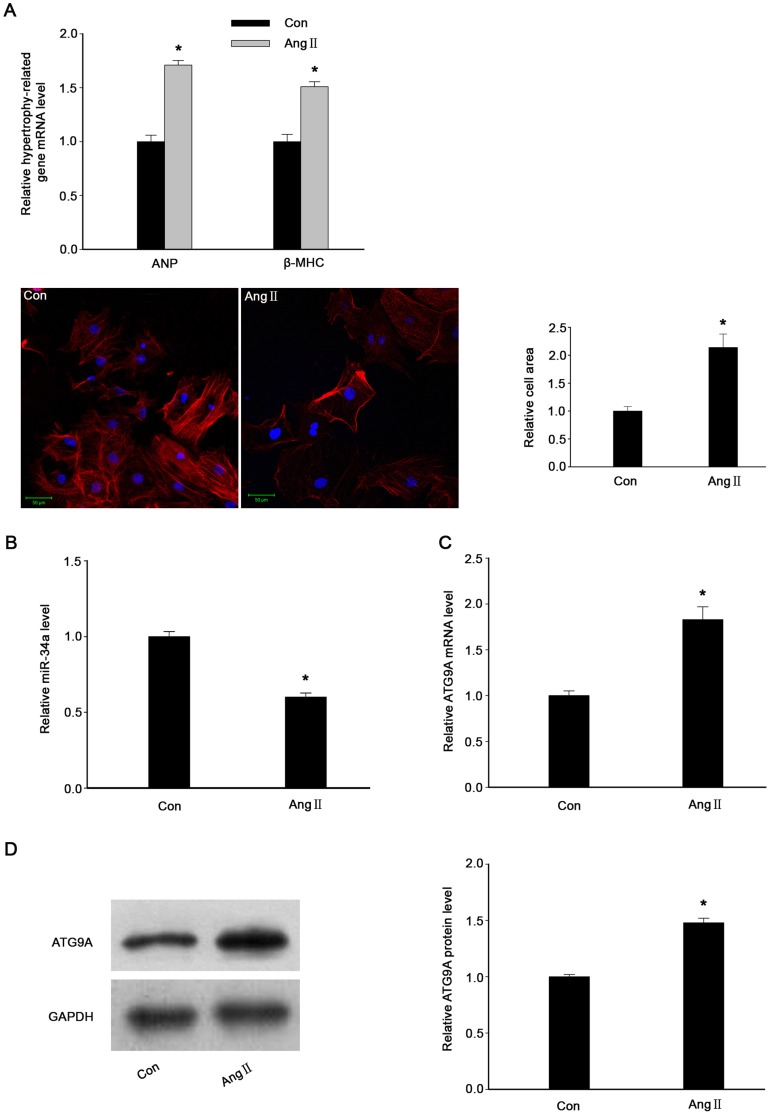
Altered miR-34a and ATG9A expression in Ang II-induced myocardial hypertrophy model in vitro.(A) Evaluation of Ang II-induced myocardial hypertrophy in terms of hypertrophy-related gene expression (ANP and β-MHC) and morphological changes. Morphological changes were measured by confocal microscopy after staining with Alexa Fluor555 Phalloidin and DIPI. The graph summarized the data on changed hypertrophy-related gene expression and cell morphology. *P<0.05 compared with controls (Con). (B) qRT-PCR detection of miR-34a. U6 was used as an internal control. Data are presented as means ± SEM. *P<0.05 compared with Con. (C) qRT-PCR analysis of ATG9A expression. 18s was used to normalize ATG9A expression. Data are presented as means ± SEM. *P<0.05 compared with Con. (D) ATG9A protein expression was analyzed by Western blotting. The graph quantified Western Blot data. *P<0.05 compared with Con.